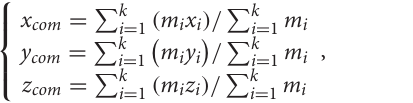
Figure 1 could be divided into three parts: Safety Perception, Gait Trajectory Generator Based on DMPs, and Robot